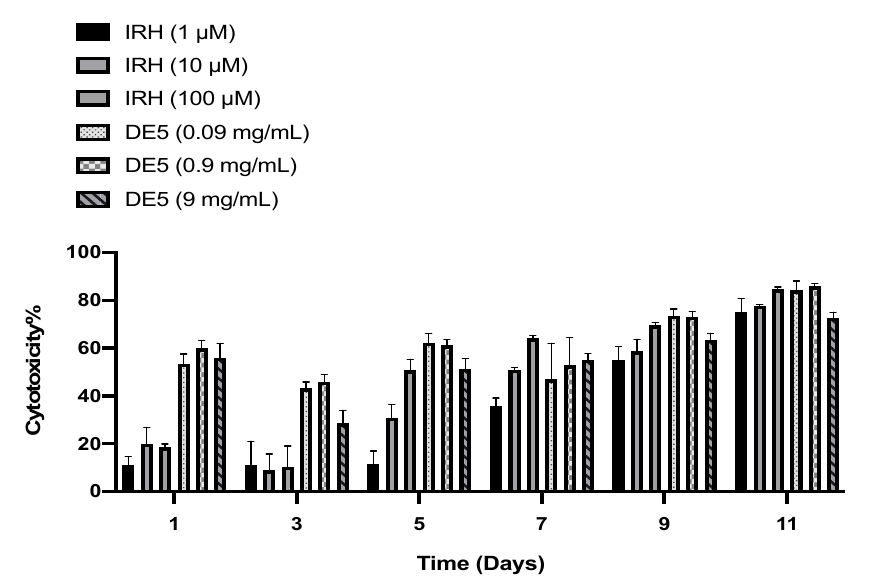
Figure 7. The cytotoxicity of free IRH and DE5 formulation on primary HGG cells.